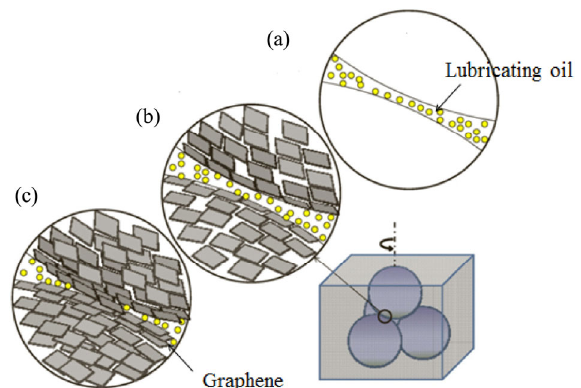
Fig. 9 Schematic of tribological experiment with lubricating oil adding a certain amount of graphene. (a) friction diagram of pure lubricating oil, (b) represents the optimal concentration of graphene in oil, (c) represents excessive concentration of graphene in oil. Reproduced with permission from Ref. [115], © IOP Publishing